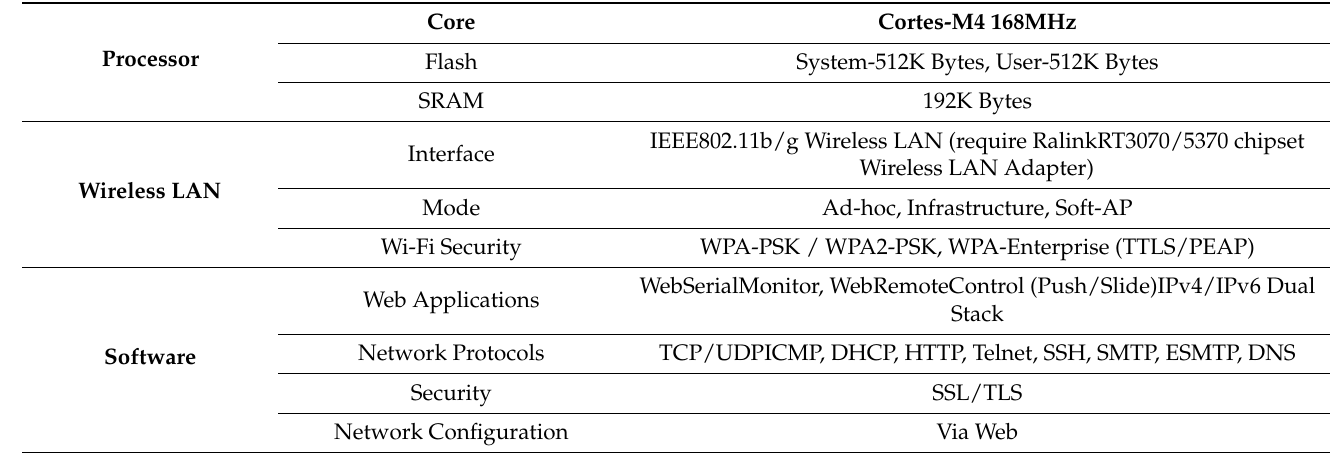
Table 1. Specification of PHPOC Wi-Fi Shield.